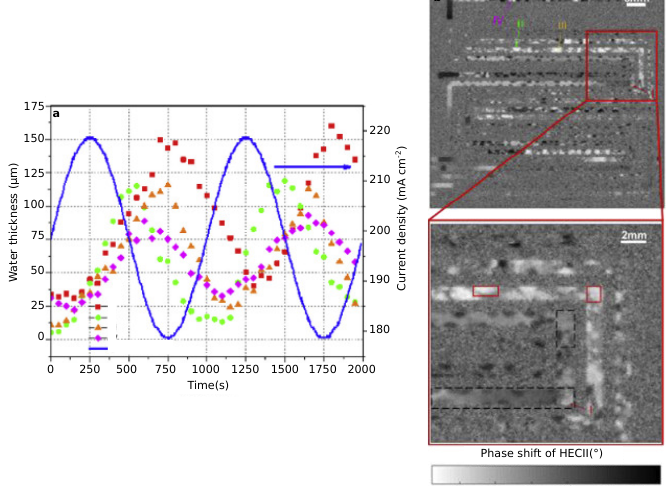
Figure 7. Hydro-electrochemical impedance imaging (HECII) technique: ( a ) Temporal data of current stimulus (blue) plotted with the water thickness response at four different locations across the active cell area, and ( b ) HECII over the period 0-2000s. Figures adapted from [15] with permission from